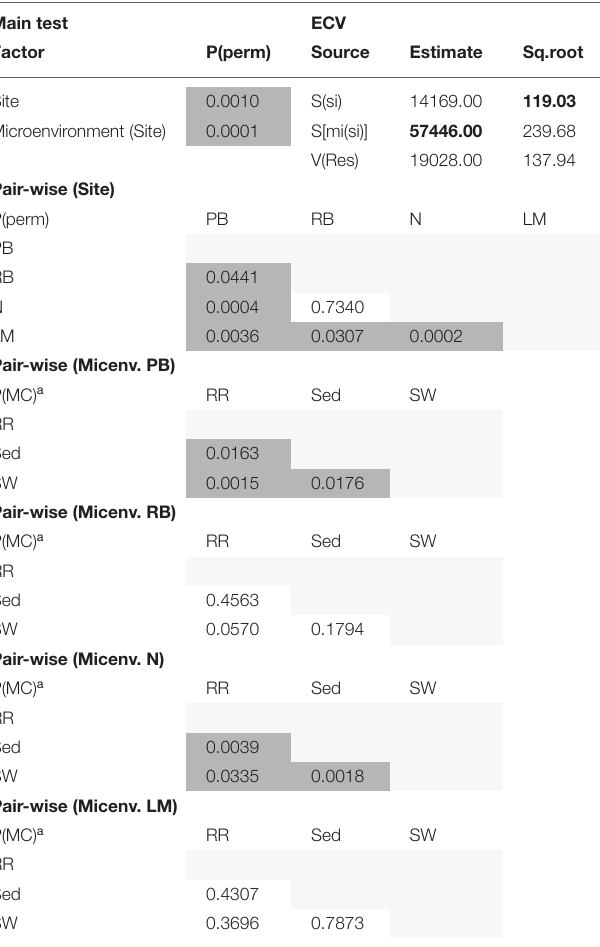
SUPPLEMENTARY TABLE 7 | Statistical analyses for fungal mean alpha diversity (Chao1 diversity).